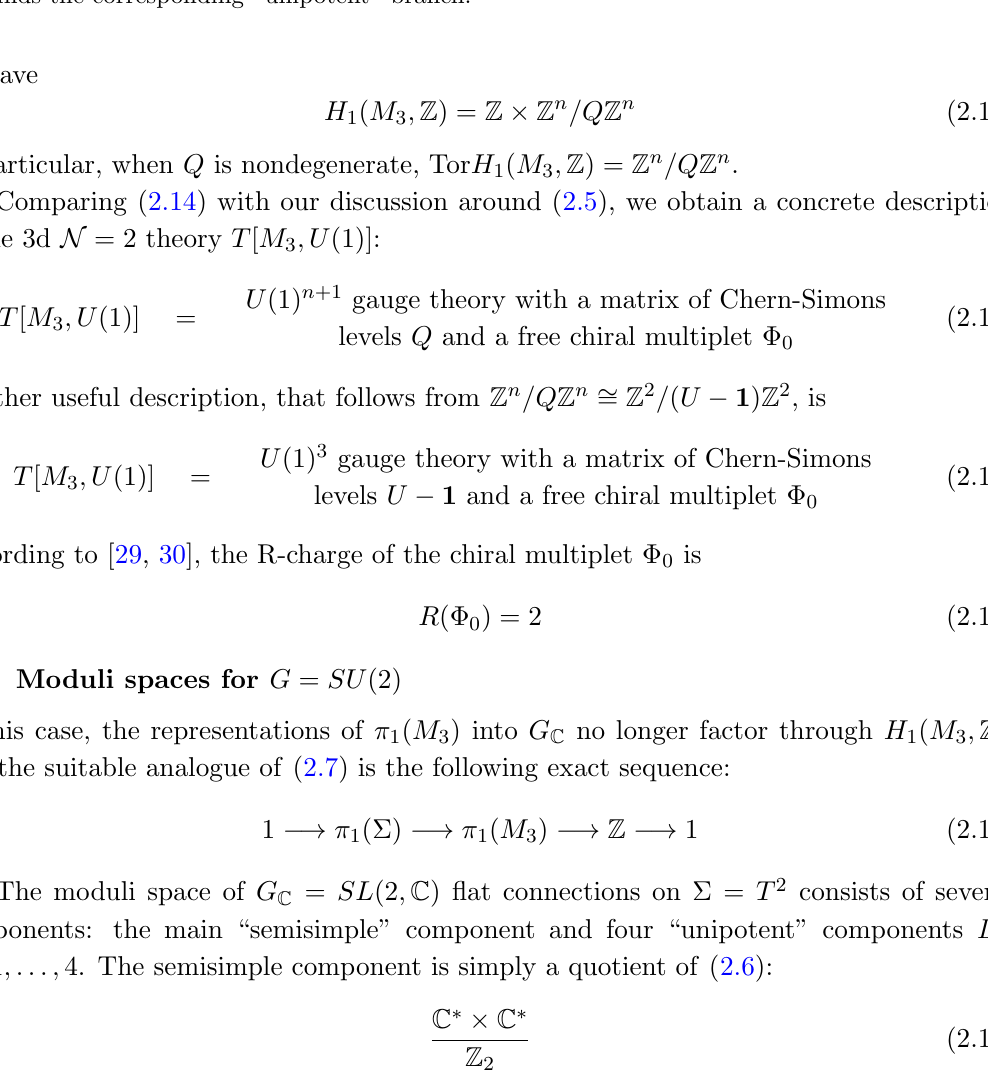
Figure 3 . The structure of the moduli space of (cid:13)at G C = SL (2 ; C ) (cid:13)at connections on (cid:6) = T 2 . Over each of the four orbifold points of the \semisimple" branch (2.19), with x = (cid:6) 1 and y = (cid:6) 1, one (cid:12)nds the corresponding \unipotent"